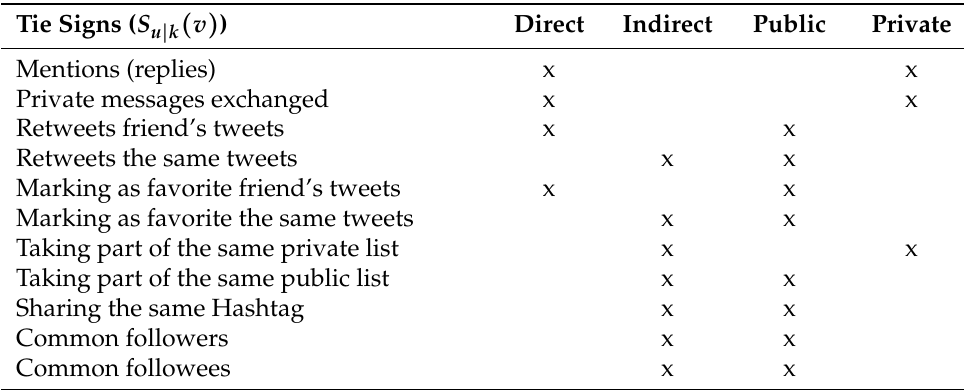
Table 2. Tie signs ( S u | k ( v ) ) classification on Twitter